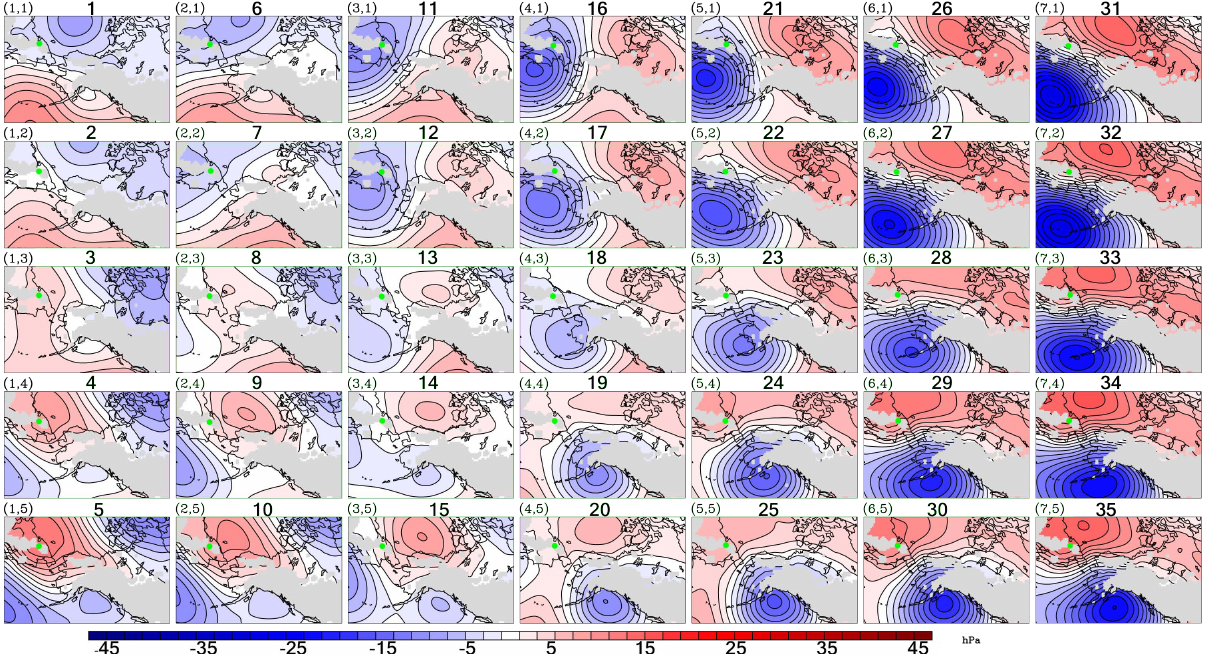
Fig. 1. SOM patterns used in this study. The sea-level pressure-patterns here capture the full range of weather experienced within the domain over the past 50yr, as described in the text. Each weather pattern can be identified with the single number above it or the (column, row) notation used in prior work; e.g., pattern 26 and (c3, r2) are the same. Green circles show approximate location of Lake